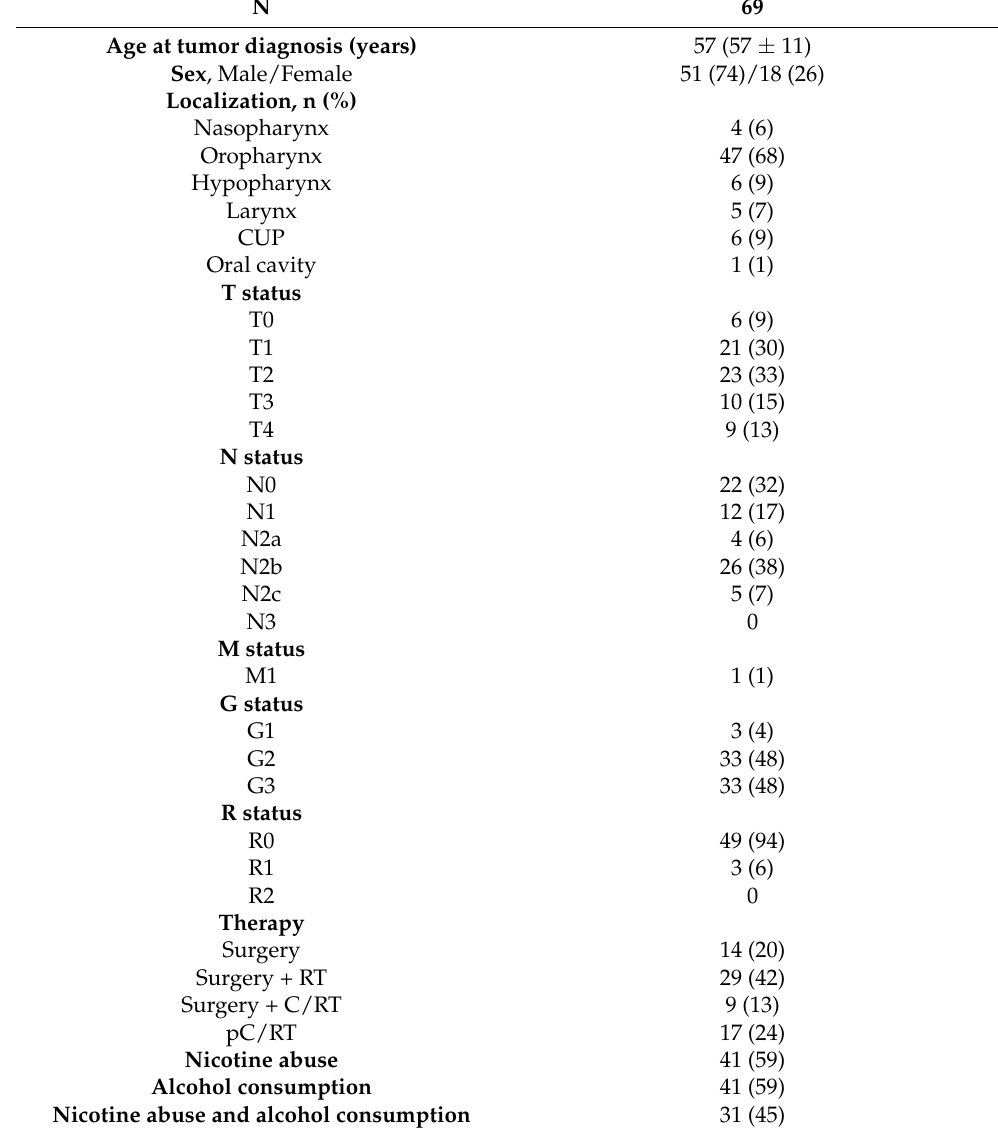
Table 1. Patient characteristics, tumor staging and grading and history of substance abuse. All data are expressed as median (mean ± standard deviation) or number